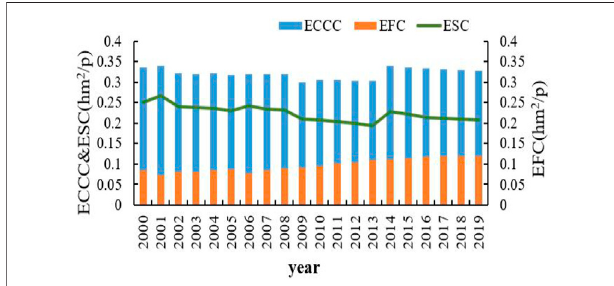
FIGURE 3 | 2000 – 2019 ECCC, EFC, and ESC of cultivated land in Sichuan